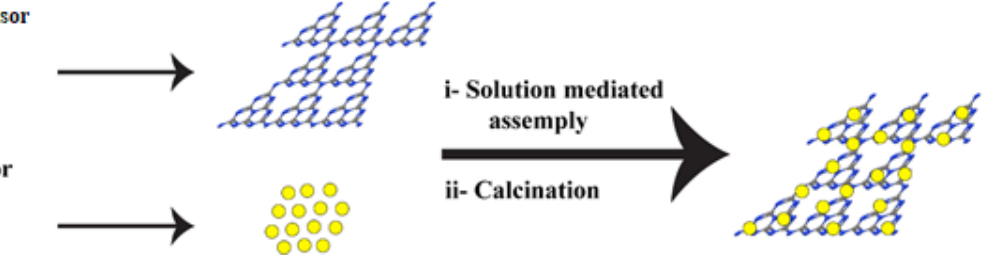
Figure 9. Schematic illustration of TiO 2 / g-C 3 N 4 heterojunctions synthesis approach. The conductive band of g-C 3 N 4 (E CB = − 1.4 eV) is higher than those of anatase TiO 2 (E CB = − 0.5 eV), so the proper bandgap alignment helps to reduce the electron-hole recombina-